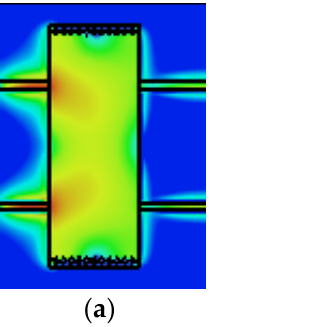
Figure 7. The surface current distributions on the SIW without slots for CM operating at f 0 . ( a ) The uniform amplitude distributions. ( b ) The vector distributions.